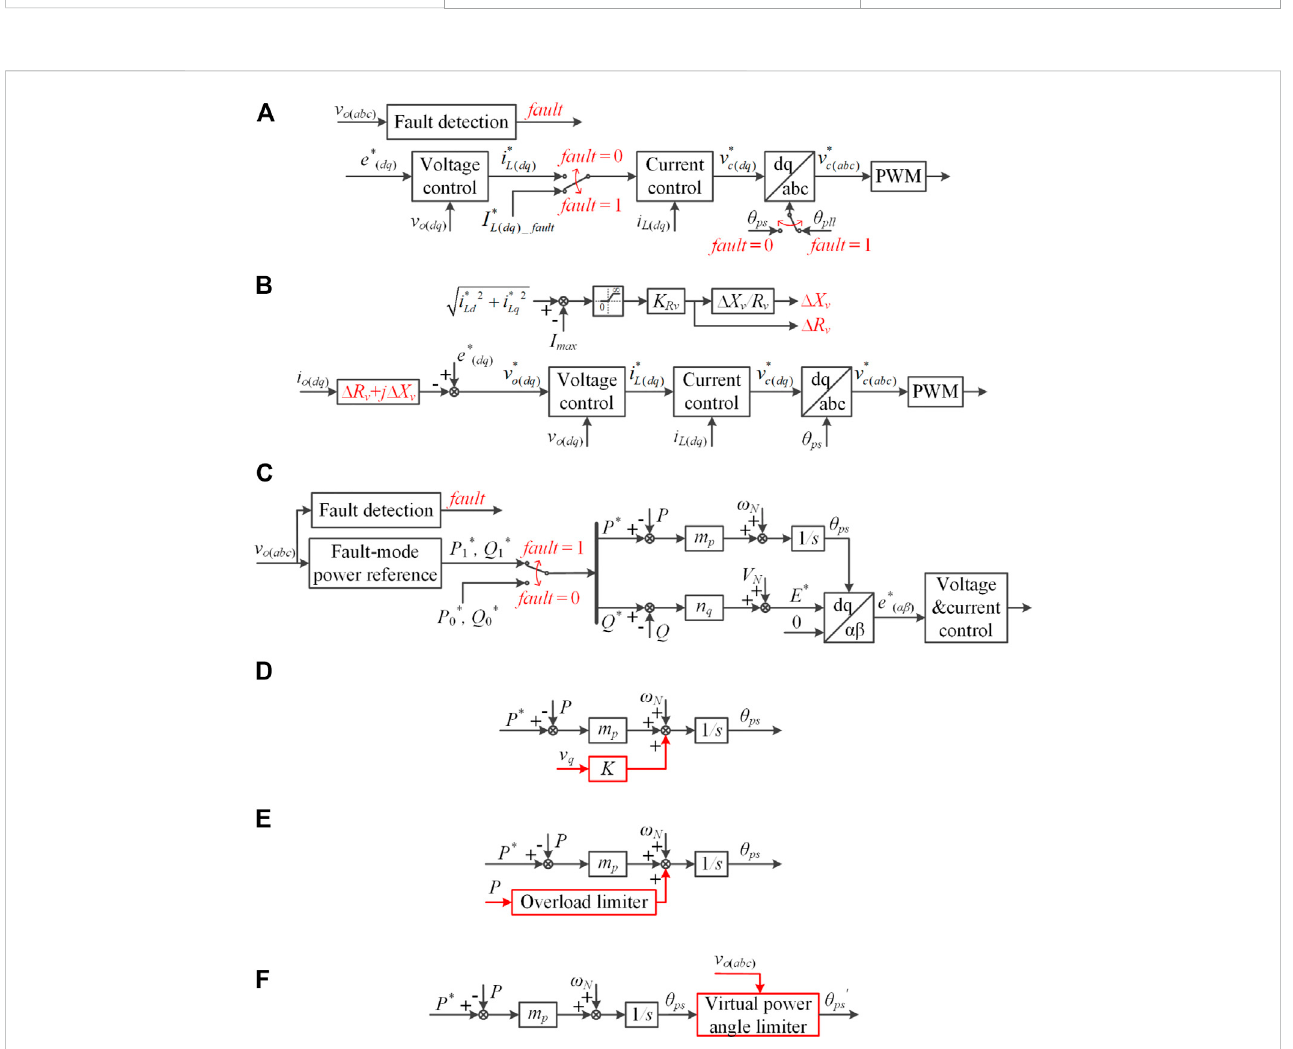
FIGURE 13 Overcurrent protection schemes of GFM converters. (A) Control-mode-switching method (Oureilidis and Demoulias, 2016), (B) Virtual impedance method (Paquette and Divan, 2015), (C) Modifying power reference method (Taul et al., 2020), (D) Voltage-based frequency feedforward method (Huang et al., 2019), (E) Power-based frequency feedforward method (Du et al., 2019), (F) Virtual power angle limiting method (Huang et al.,